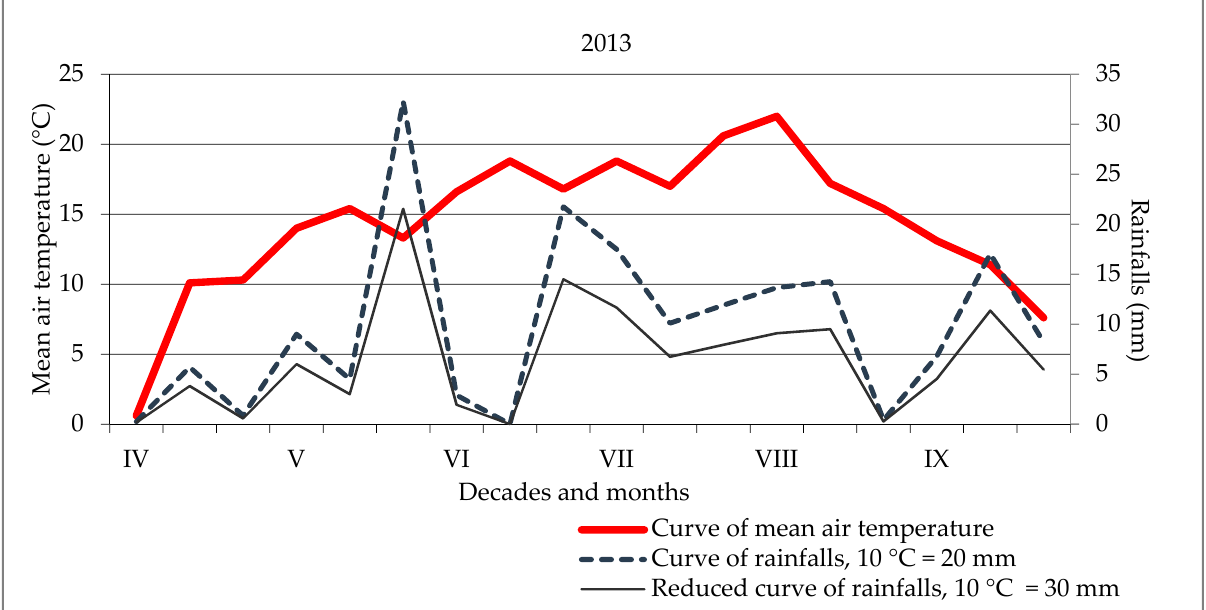
Figure 3. Climatic diagram for meteorological conditions from April to September (IV–IX) in 2013.